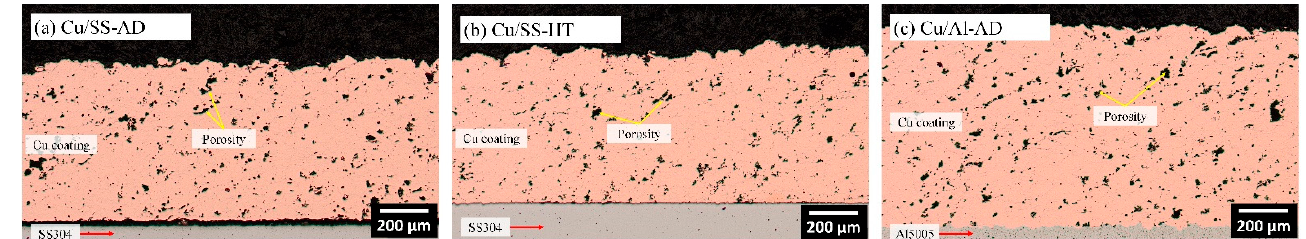
Figure 8. Optical micrographs showing copper coatings on SS304 substrate in ( a ) as-deposited and ( b ) heat-treated states, and on ( c ) Al5005 substrate in as-deposited state. Note: Yellow arrows show the porosities in the copper coatings, and red arrows show the substrate.